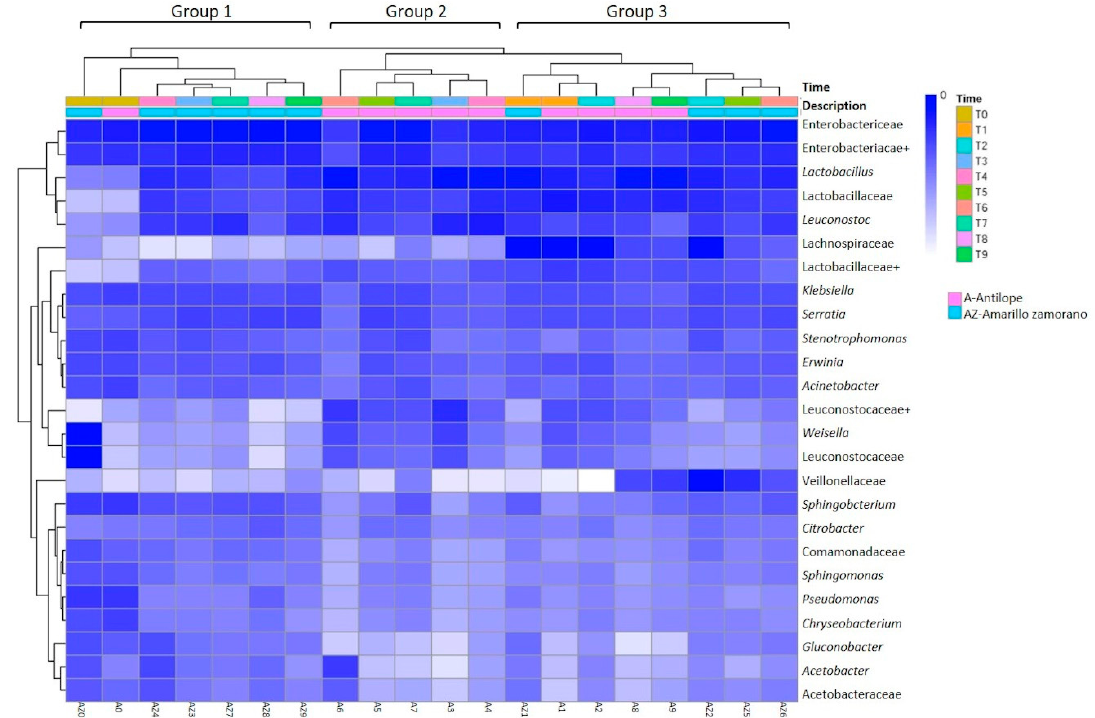
Figure 3. Heatmap plot illustrating the top 25 bacterial operational taxonomic units (OTUs) ( Y -axis) of the silage samples ( X -axis). The relative values for bacterial OTUs are depicted by the color intensity with the legend indicated at the bottom of the figure. Clusters based on the distance of the samples along the X -axis and the bacterial OTUs along the Y -axis are indicated in the upper and left of the figure, respectively.